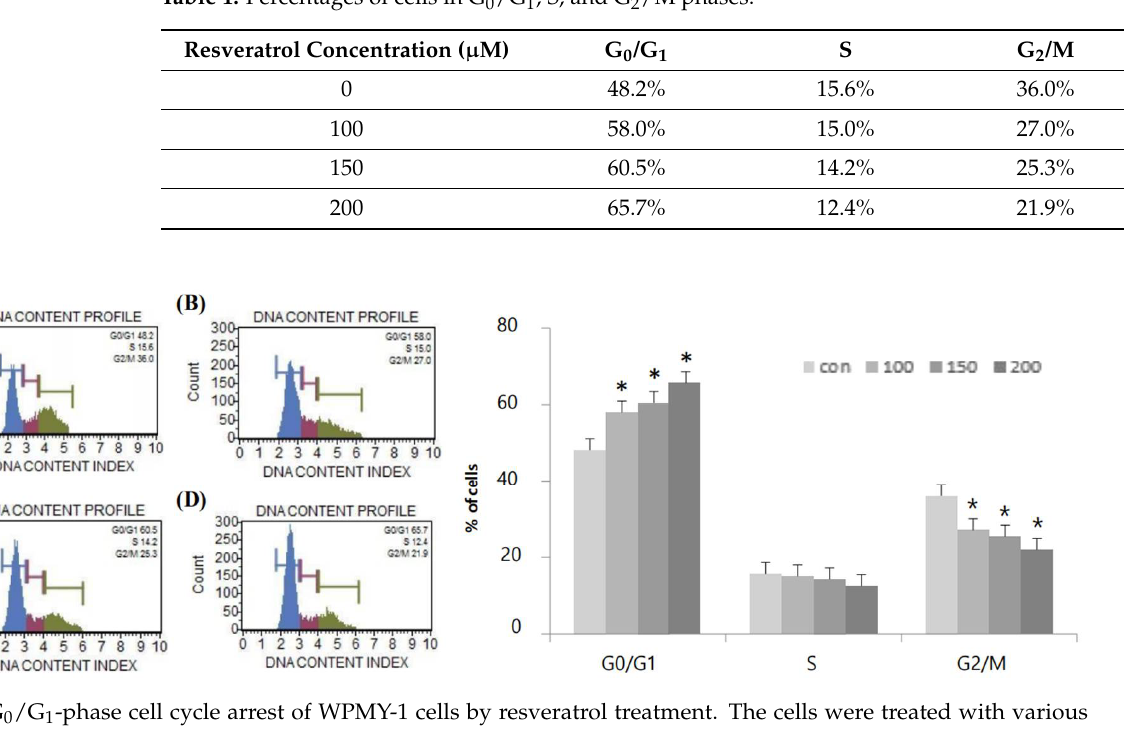
Figure 3. G 0 /G 1 -phase cell cycle arrest of WPMY-1 cells by resveratrol treatment. The cells were treated with various resveratrol concentrations (0, 100, 150, and 200 µ M) for 24 h. Flow cytometry analysis was performed to analyze the cell cycle distribution in WPMY-1 cells treated with resveratrol. The results for each concentration are as follows: ( A ) 0 µ M, ( B ) 100 µ M, ( C ) 150 µ M and ( D ) 200 µ M. The data are expressed as mean ± SD as a result of three independent experiments depending on the resveratrol concentration (* p < 0.05).